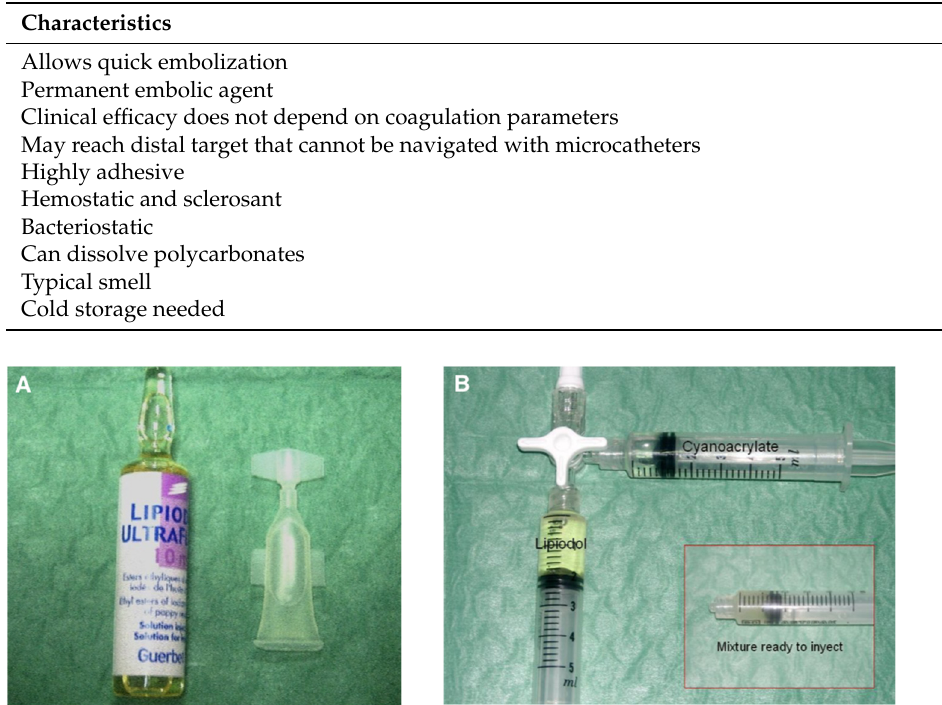
Table 2. Common cyanoacrylate glue features.